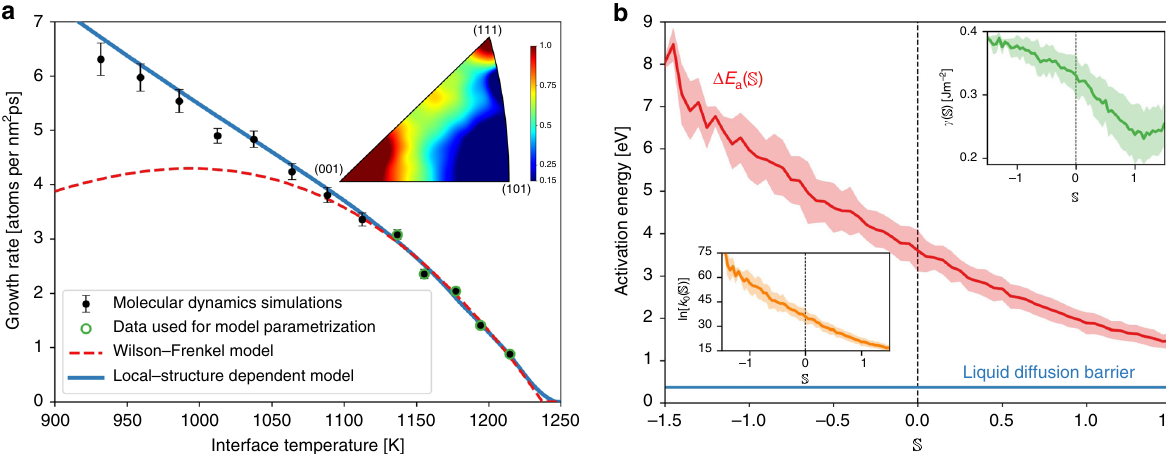
Fig. 7 Local-structure dependent model of crystal growth for copper. a Crystal growth rate versus interface temperature for copper. Both models (Wilson – Frenkel and local-structure-dependent model) were parametrized using only the data from simulations at T ≥ 1137K. The error bars represent the 95% con fi dence interval around the mean (see “ Methods ” section). b Dependence of the activation energy for solidi fi cation on softness ( S ). The inset shows the interface free energy and the Arrhenius prefactor. The interface-induced ordering of the liquid affects the process of crystal growth of metals in the same manner as it was observed for silicon. The major difference when compared to the results for silicon is that k 0 ð S Þ and Δ E values due to the predominance of rough interfaces in metallic systems. Error bars are standard